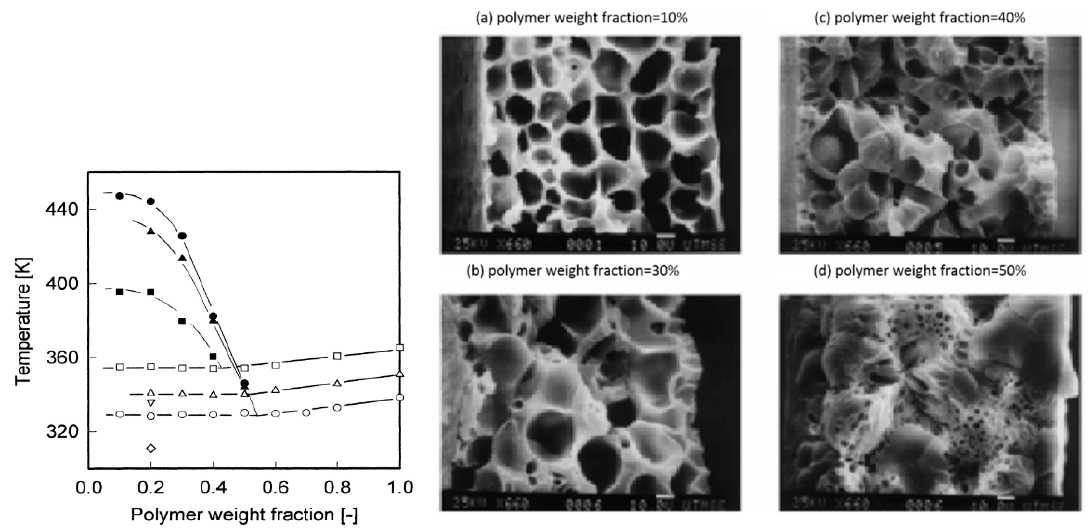
Figure 6. The effect of polymer concentration on the final membrane morphology. ( Left ) Dynamic phase diagrams of the polymer–diluent systems. ( ■ ) PE-DPE, ( ▲ ) Iotek7030-DPE and ( ● ) Iotek4200-DPE. ( Right ) Micrographs of the resulting PE membranes cross-sections with a cooling rate of 10 °C/min, adapted from [66] .